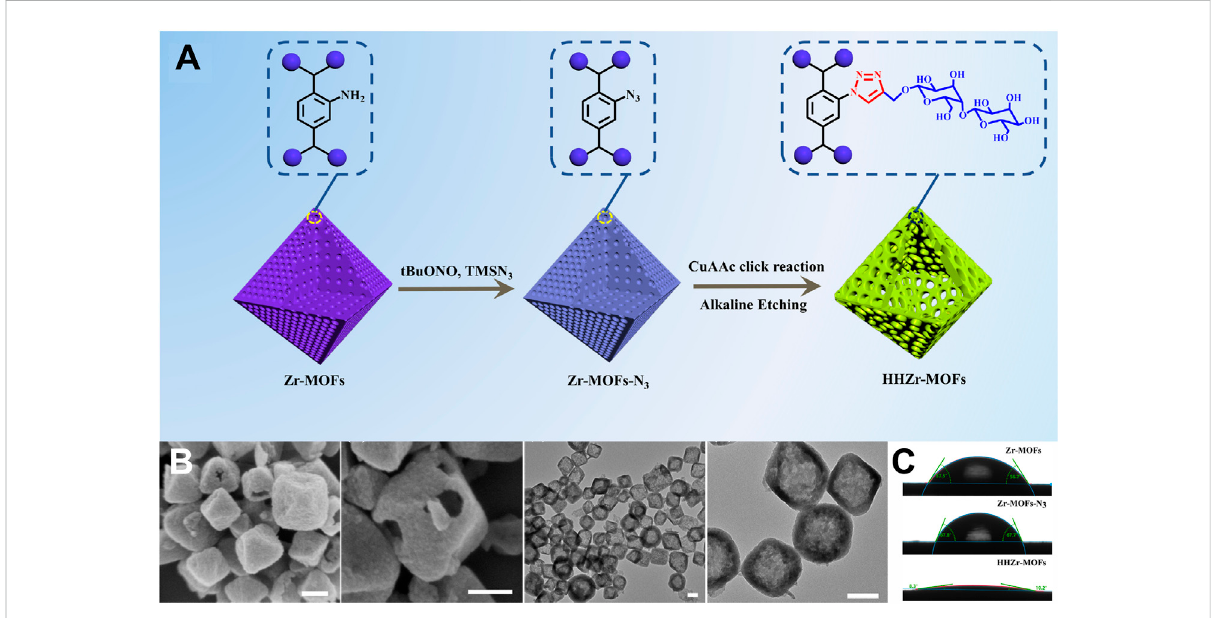
FIGURE 3 (A) Synthetic procedure of HHZr-MOFs. (B) SEM images and TEM images of HHZr-MOFs. (C) Contact angles of Zr-MOF s , Zr-MOFs-N 3 and HHZr-MOF s . Reproduced from (He et al., 2022) with permission from